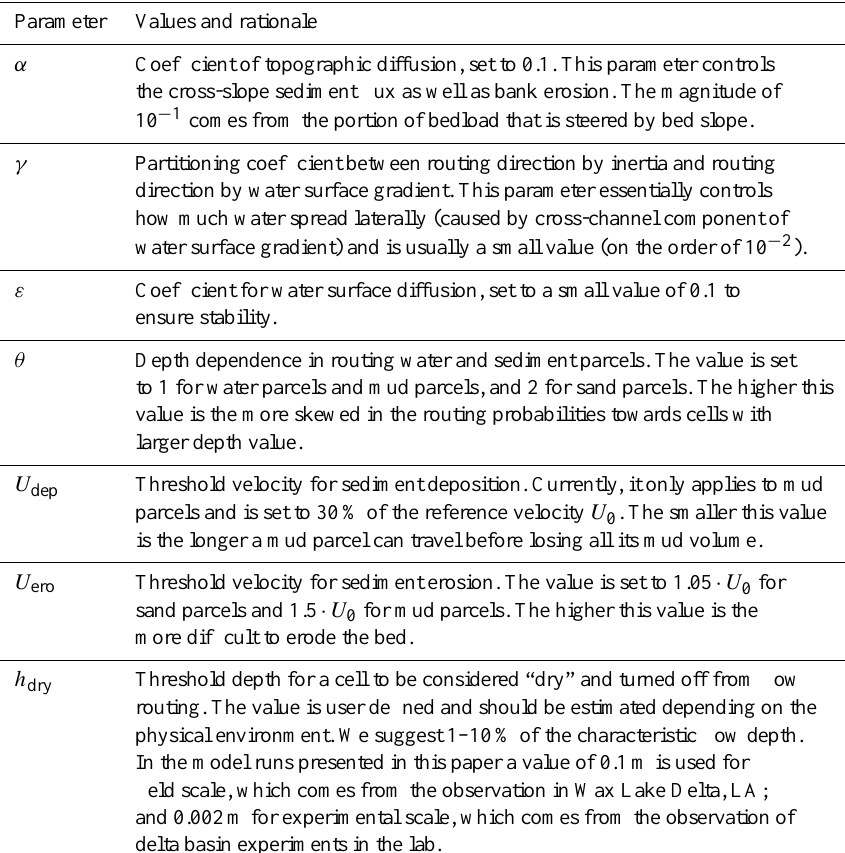
Table 1. List of model constants and parameters. Parameter Values and rationale α Coefficient of topographic diffusion, set to 0.1. This parameter controls the cross-slope sediment flux as well as bank erosion. The magnitude of Partitioning coefficient between routing direction by inertia and